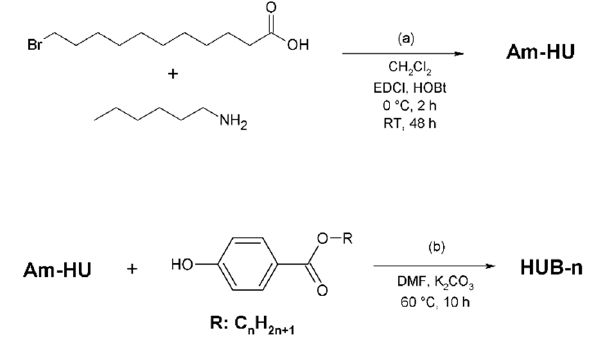
Figure 10. Synthesis of (a) bromoamide Am-HU, (b) products HUB-3 and HUB-4 ( n = 3, 4).